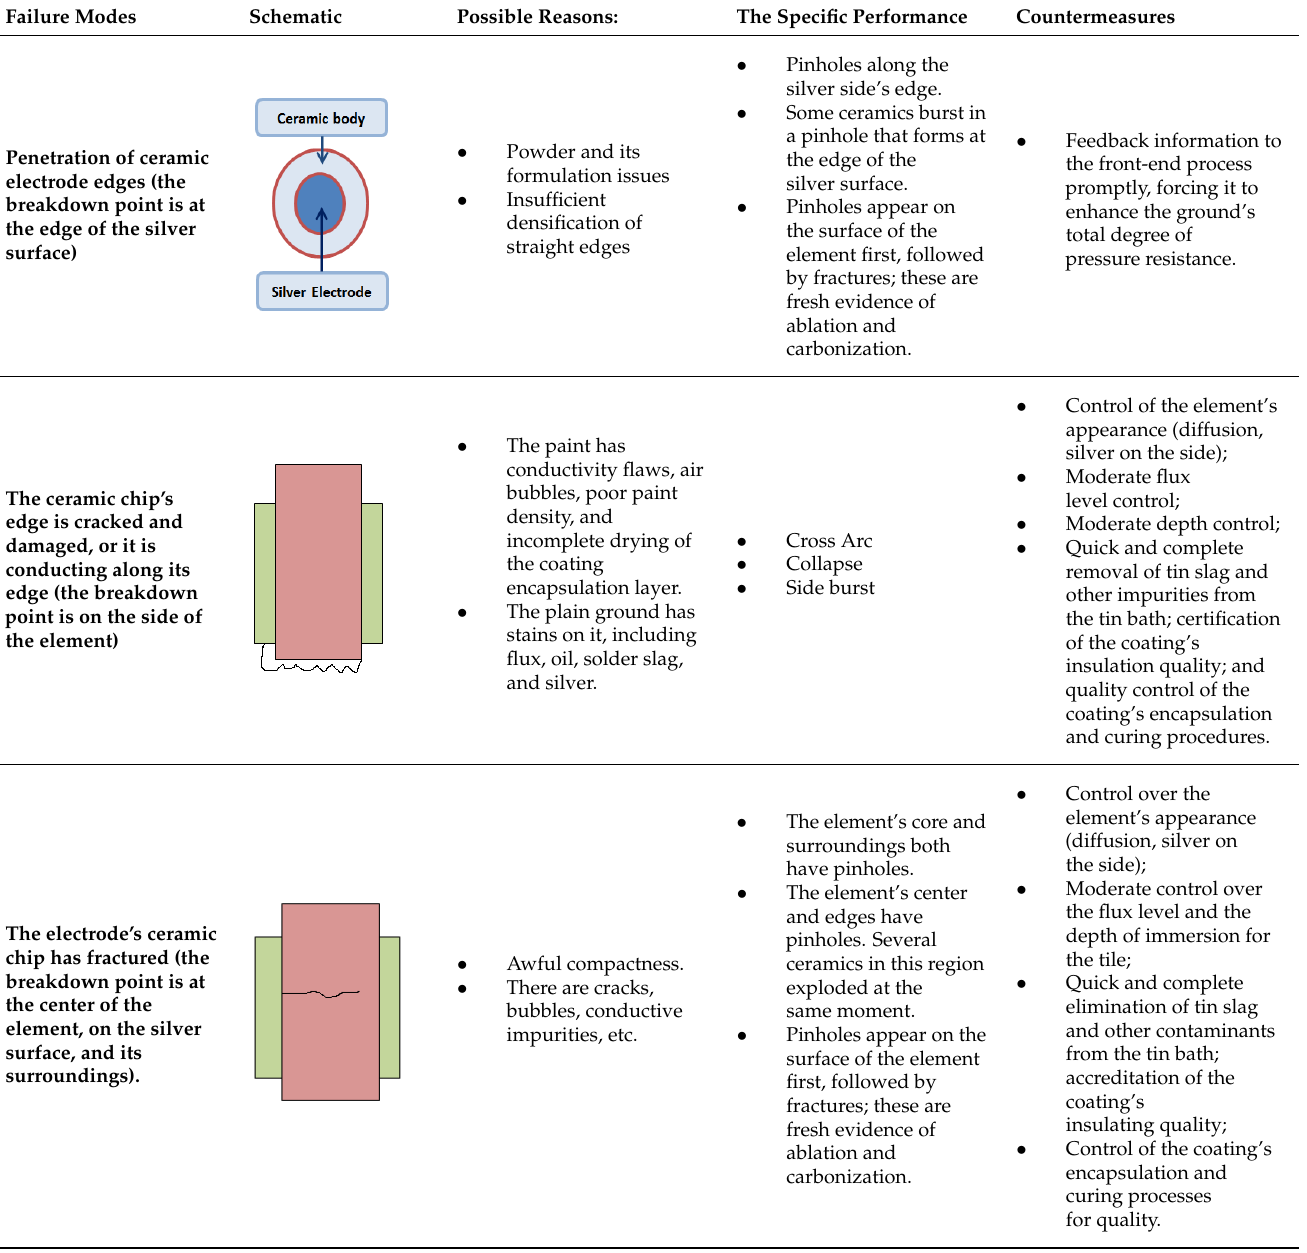
Table 3. Summary of MLCCs failure mechanisms.